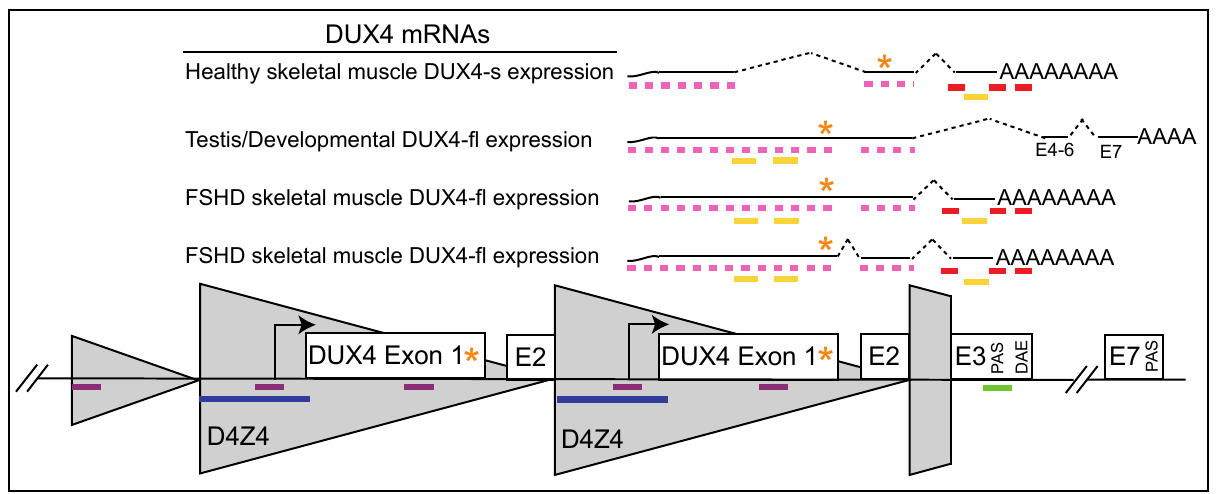
Figure 2. Therapeutic targets within the FSHD locus. Two D4Z4 repeats (grey) of a disease-permissive allele are depicted, along with distal sequences. Exons 1 and 2 are located within the repeat, and exon 3 is located in the distal sequence. Full-length DUX4 transcripts ( DUX4-fl ) are expressed in cleavage-stage embryos and stabilized by a polyadenylation signal (PAS) in exon 7. Following this stage, expression of DUX4-fl is normally silenced in most somatic tissues, although the locus can produce unstable, nonpathogenic, short DUX4 isoforms (not shown). In FSHD myocytes, incomplete somatic silencing at the locus mediates a switch from the production of these nonpathogenic isoforms to pathogenic DUX4-fl transcripts, which are stabilized by an exon 3 PAS within permissive haplotypes. Regions for therapeutic targeting are indicated by colored bars: antisense oligonucleotides (pink and red bars; the latter are reported sequences), microRNAs (yellow bars), CRISPR inhibition/epigenetic modulation (purple bars), CRISPR editing (green bar), and small interfering RNAs recruiting the Dicer/Argonaute silencing system (blue bar). The orange asterisks indicate DUX4-FL stop codon. Additional abbreviation: DAE, distal auxiliary element.